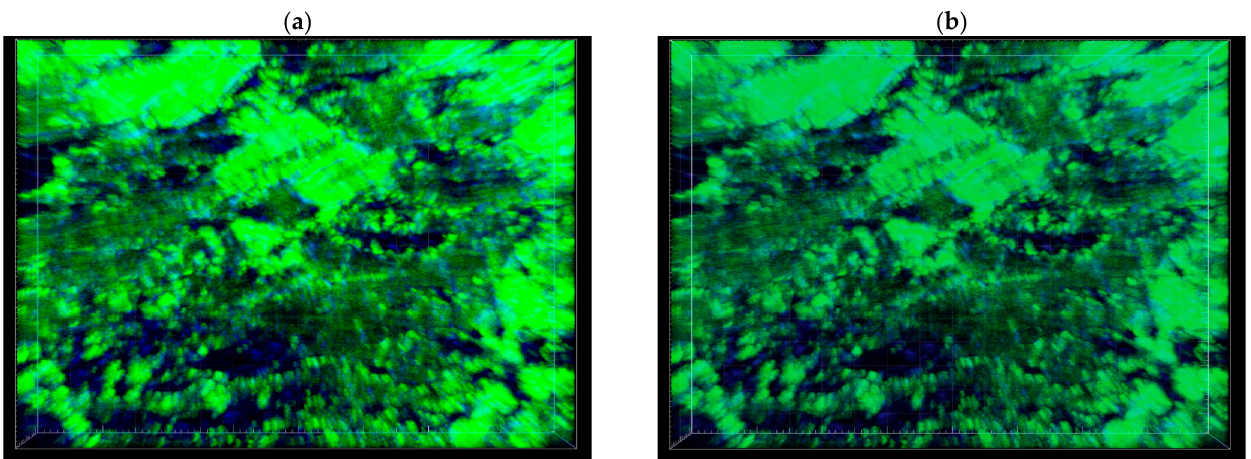
Figure 3. Temperature dependence of the intensity of gray scale obtained by color texture analysis (CTA) before and after photobleaching procedure. Textures of the SmC* A phase registered during cooling with rate 1 °C/min in MHPOBC + 0.1wt.%DANS, cross polarizers, 100 °C.